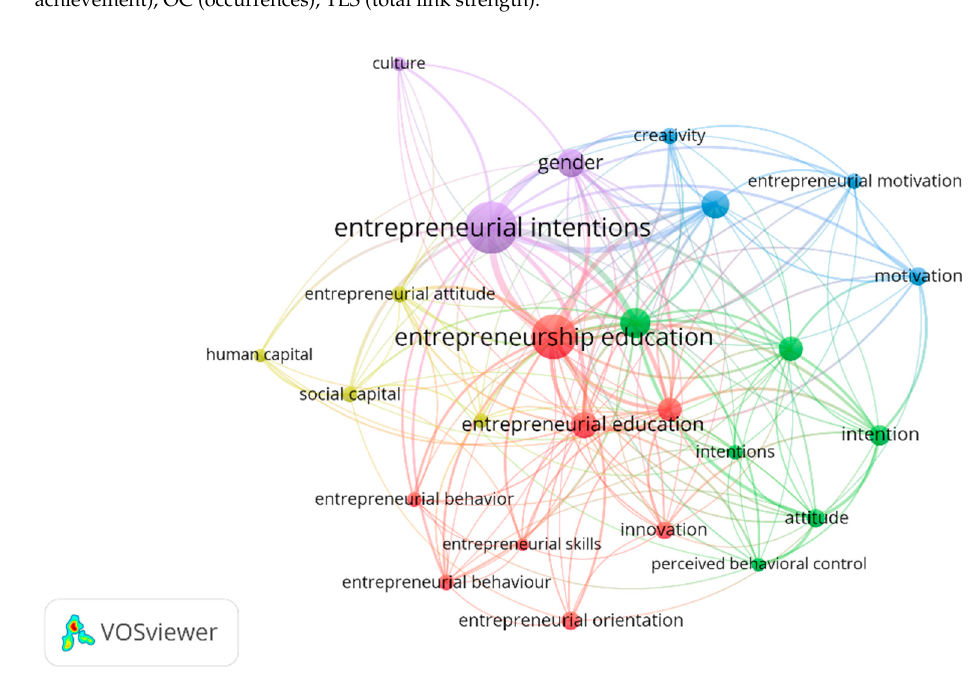
Figure 1. Network visualization (entrepreneurial intention—SCOPUS). Cluster 1 (Green), Cluster 2 (Red), Cluster 3 (Blue), Cluster 4 (Yellow), Cluster 5 (Violet).